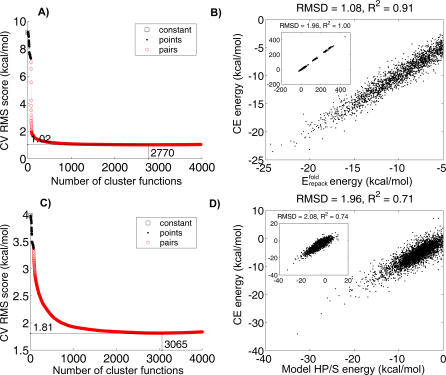
Cluster Expansion of Coiled-Coil Energies(A) and (B) refer to the CE of

; in (C) and (D), energies from model HP/S [35] were used.
(A) and (C) represent the evolution of the CV score (the progress of the fit) as the number of CFs was increased, with the type of CF added at each point (i.e., constant, point, or pair) indicated by color. The ordering of the points is described in Materials and Methods. The set of CFs and ECI used in the final expansion was taken from the point with the minimal CV score, which is indicated on the graphs.(B) and (D) show the performance of the respective CEs on predicting energies of 4,000 random sequences not included in the training sets. Insets show the entire range of energies, whereas only sequences with reasonably low energies are shown in the main plots.